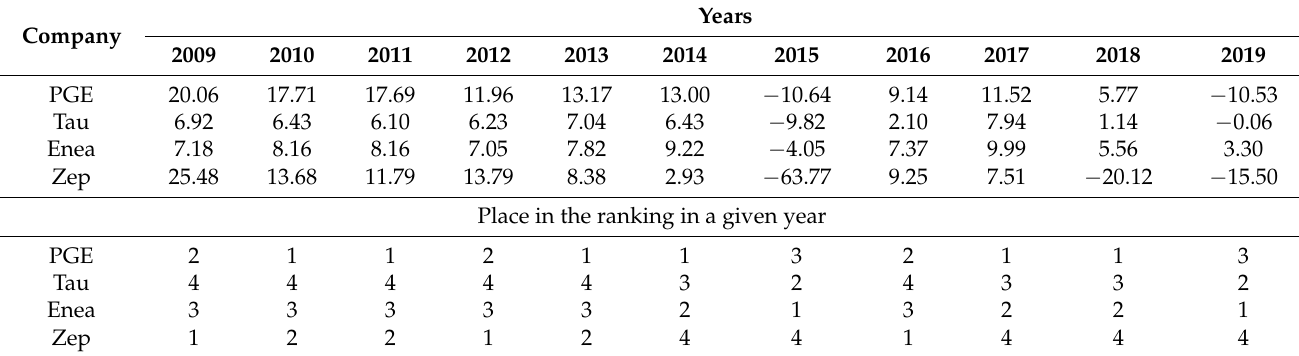
Table A3. ROS (%) ratios and the position of companies in the ranking in the years 2009–2019.